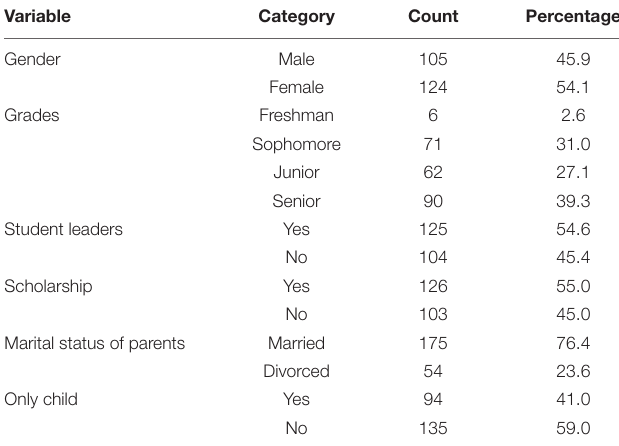
TABLE 3 | Descriptive statistical analysis results.